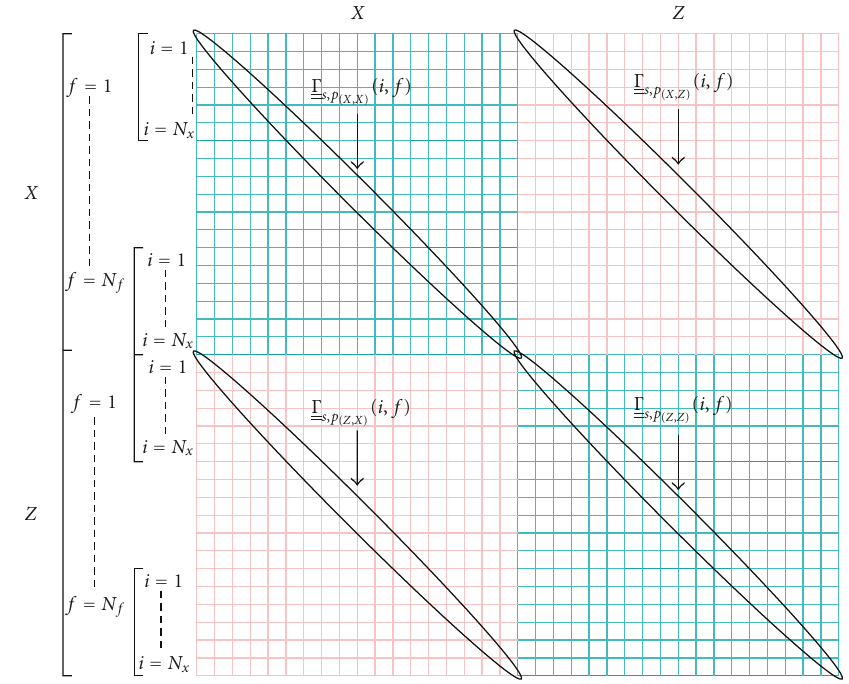
Figure 2: Diagram of Γ , the 2-Component wideband spectral matrix of the wave s , p